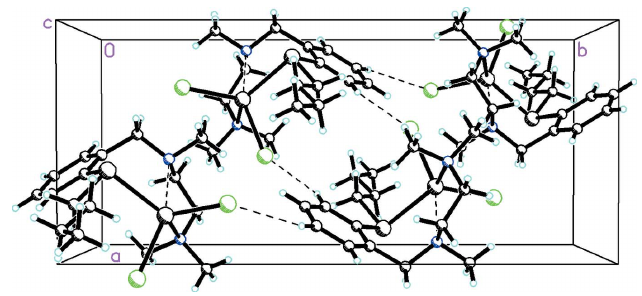
Figure 2 Packing diagram of the title compound viewed along the c axis